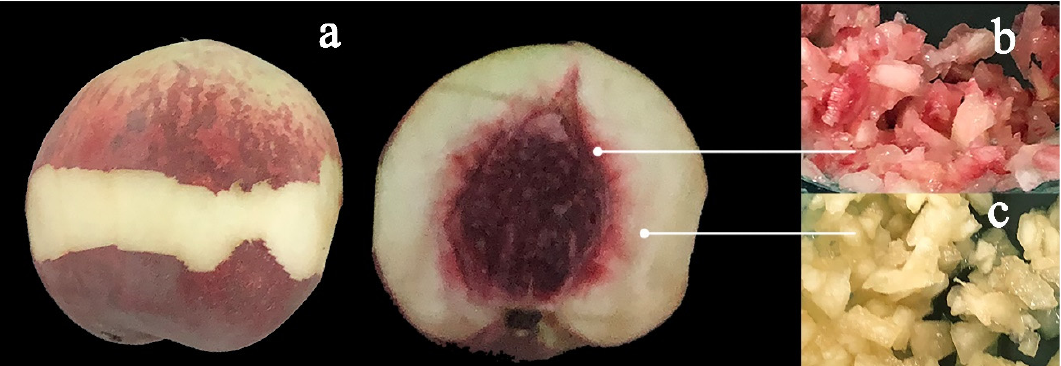
Figure 1. The peel taken from the equator of peach fruit ( a ). Red flesh ( b ) and white flesh ( c ) from the peach fruit.